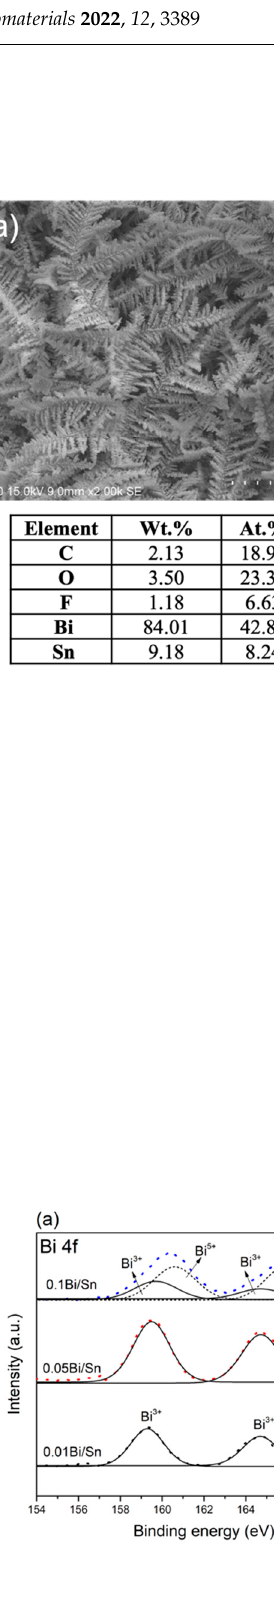
Figure 2 . XPS spectra of ( a ) Bi 4f, ( b ) O 1s, (c ) Sn 3d, ( d ) C 1s, ( e ) F 1s, and ( f ) survey spectra of Bi/Sn electrodes. 3.2. Electrochemical Measurement To determine the applied potential in CO 2 RR, the linear sweep voltammetry (LSV) was carried out to compare the onset potential of hydrogen evolution reaction (HER) and CO 2 RR. In N 2 -saturated electrolytes (dashed line), the onset potentials were assigned to HER; in the CO 2 -saturated electrolyte (solid line), the onset shift could be assigned to CO 2 RR [22]. The LSV curves in Figure 3 revealed that the onset potential shifts for all the Bi/Sn electrodes in CO 2 -saturated electrolytes were in the range of − 1.3 to − 1.4 V vs. Ag/AgCl, suggesting that the size of bismuth dendrites on Bi/Sn electrodes did not affect the onset potential shift of CO 2 RR under our electrolyte system. Figure 3 . Linear sweep voltammetry (LSV) curves of the Bi/Sn electrodes in N 2 (dashed line) and CO 2 -saturated (solid line) electrolyte.